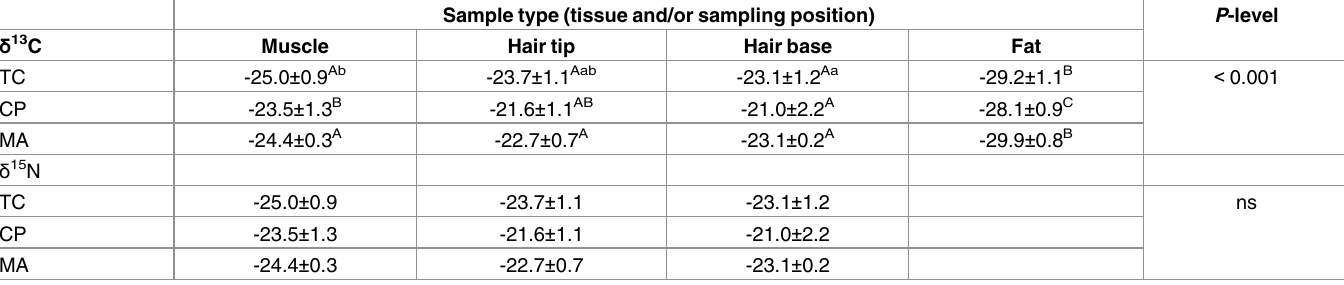
Table 4. C and N isotopic compositions (mean ± SD) of muscle, hair tip, hair base, and fat of free-living wild boar harvested in different areas. Sample type (tissue and/or sampling position)